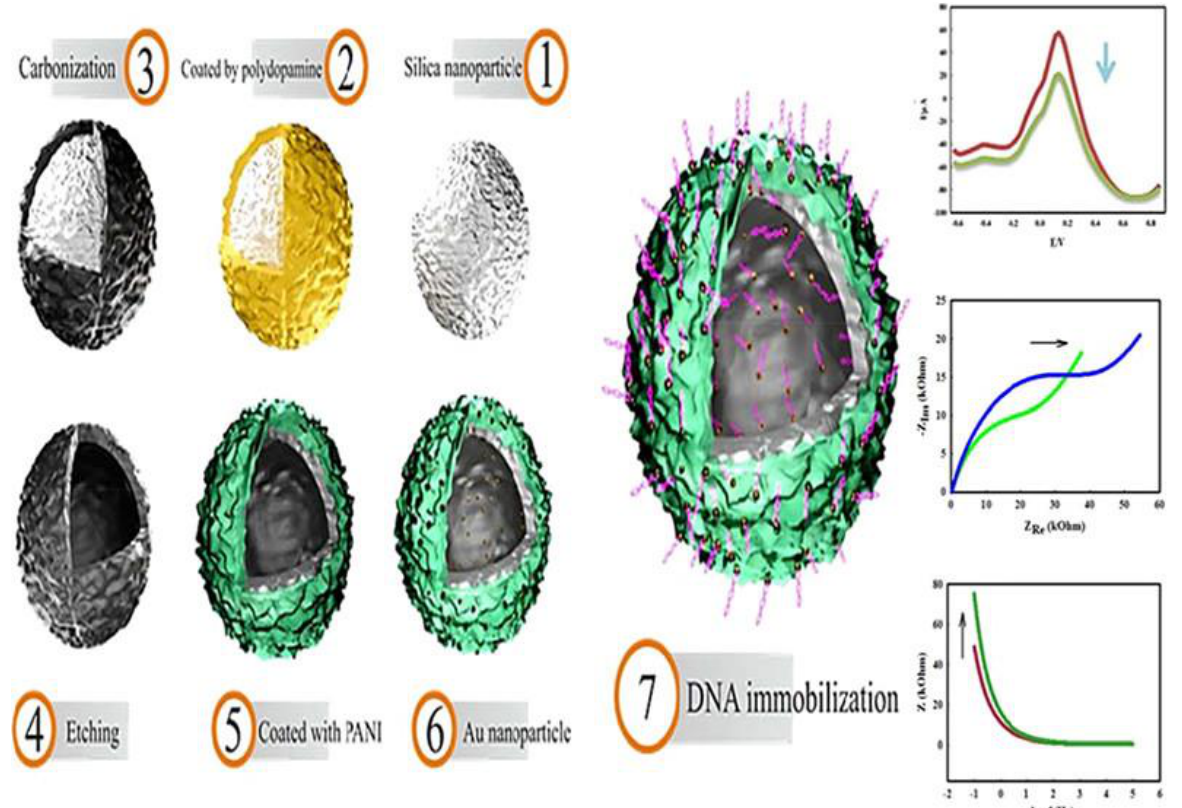
Figure 7. Schematic illustration of electrochemical DNA sensor based on hollow carbon spheres decorated with PANi. Adapted with permission from [63]. Copyright 2019, American Chemical Society.